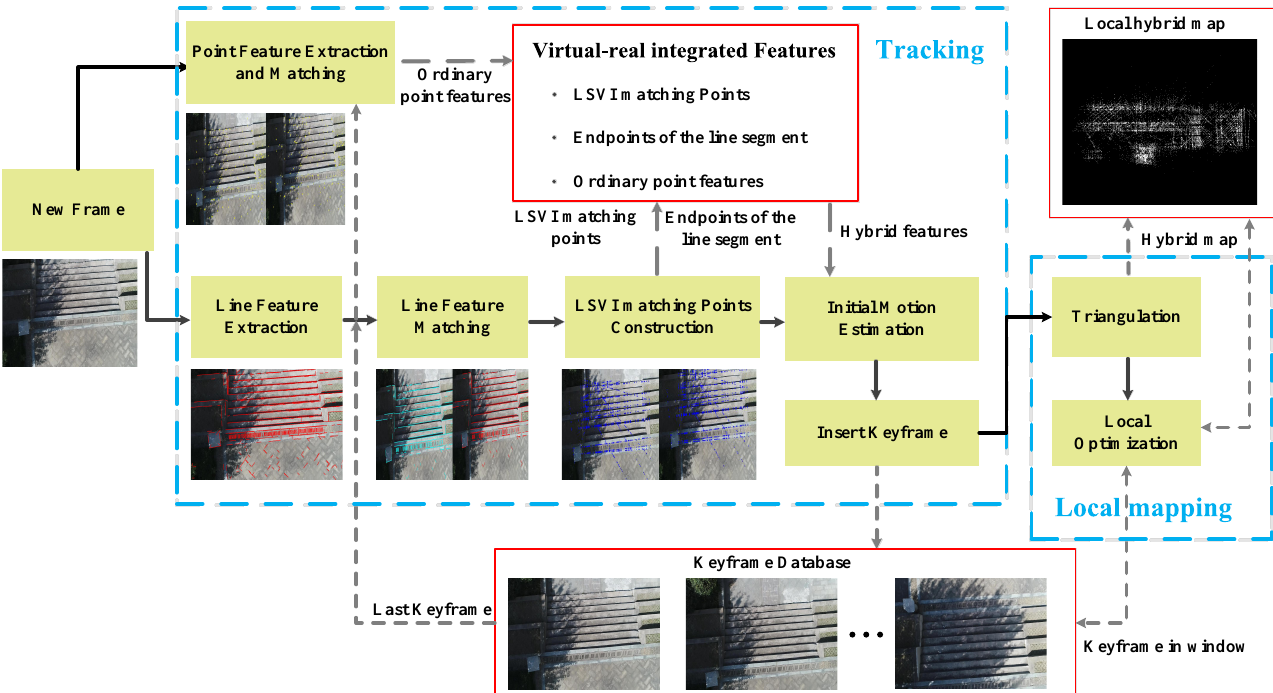
Figure 7. Framework of the proposed virtual-real hybrid map based monocular VO algorithm. The algorithm includes two threads: tracking and local mapping. The black arrows denote the connection of steps and the gray dashed lines denote the data transfer in different